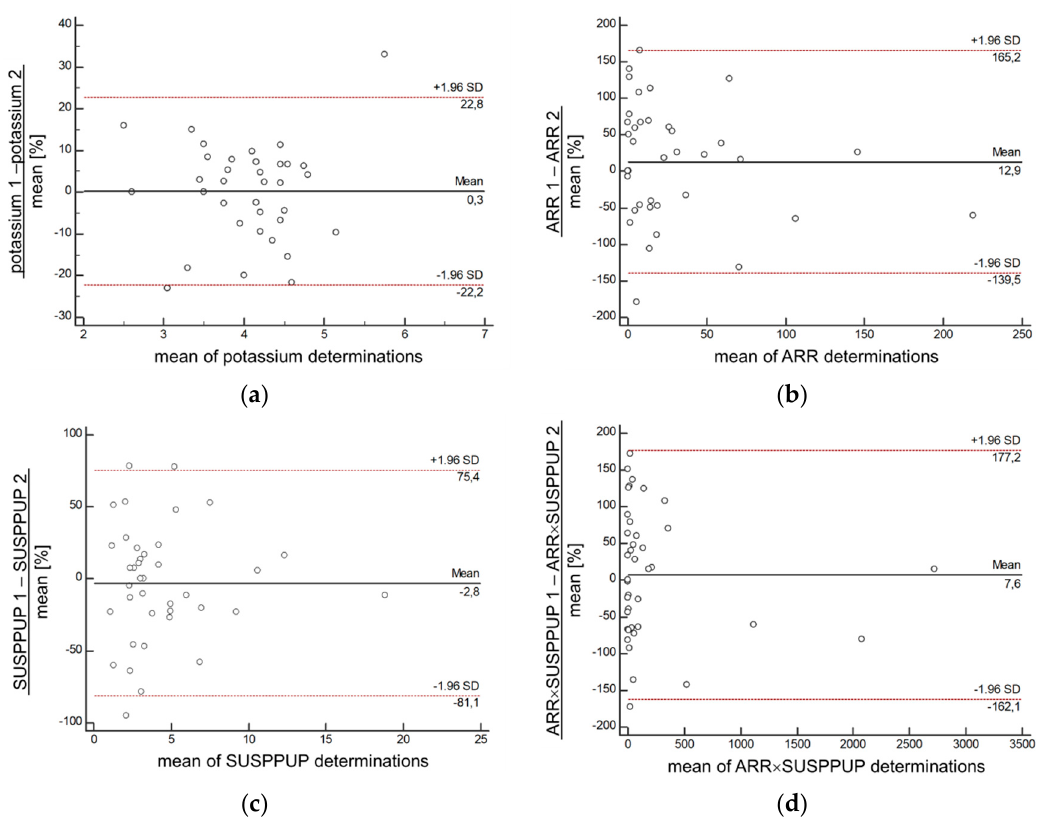
Figure 2. This figure shows Bland–Altman-plots to illustrate the difference between two determinations of serum potassium ( a ), the aldosterone to renin ratio ( b ), the serum sodium to urinary sodium divided by (serum potassium) 2 to urinary potassium (SUSPPUP) ratio ( c ) and the product of both ( d ). Red dot line is line of 1.96 standard deviations.